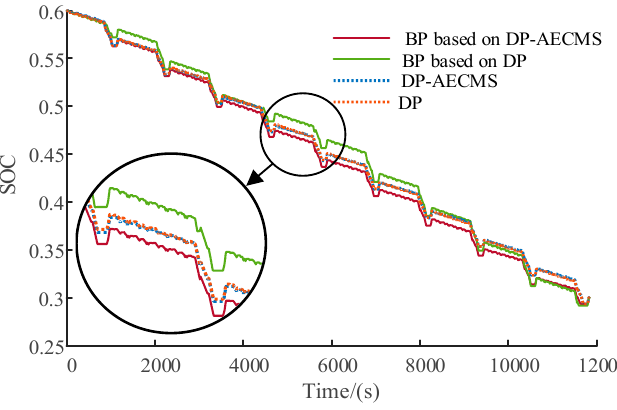
Figure 11. Equivalent factors of the neural network strategy, ( a ) Recognition error of BP neural network; ( b ) Allowable range of equivalent factor.